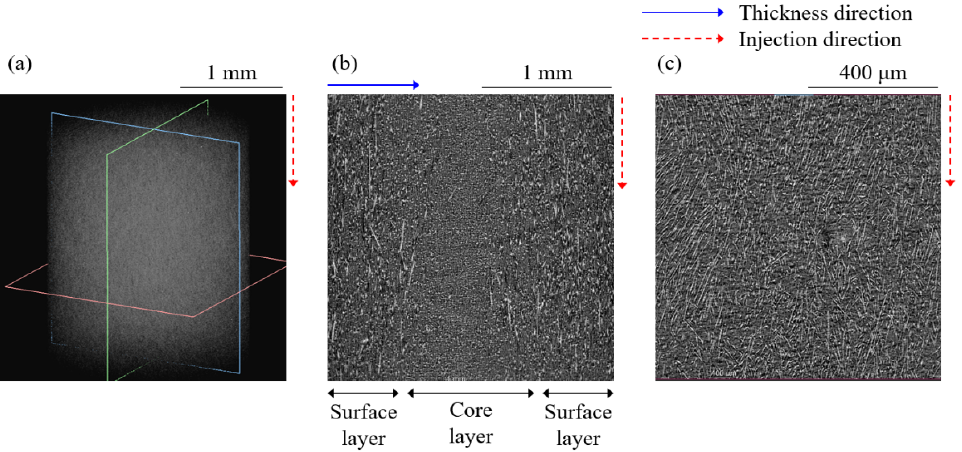
Figure 10. The XCT images from PA6-CF injection molded plate. Fibers and matrices appear as white and grey elements. ( a ) Full 3D view of a single XCT data. ( b ) Surface and core layer along thickness and injection direction. ( c ) Surface layer view from normal to the thickness direction.